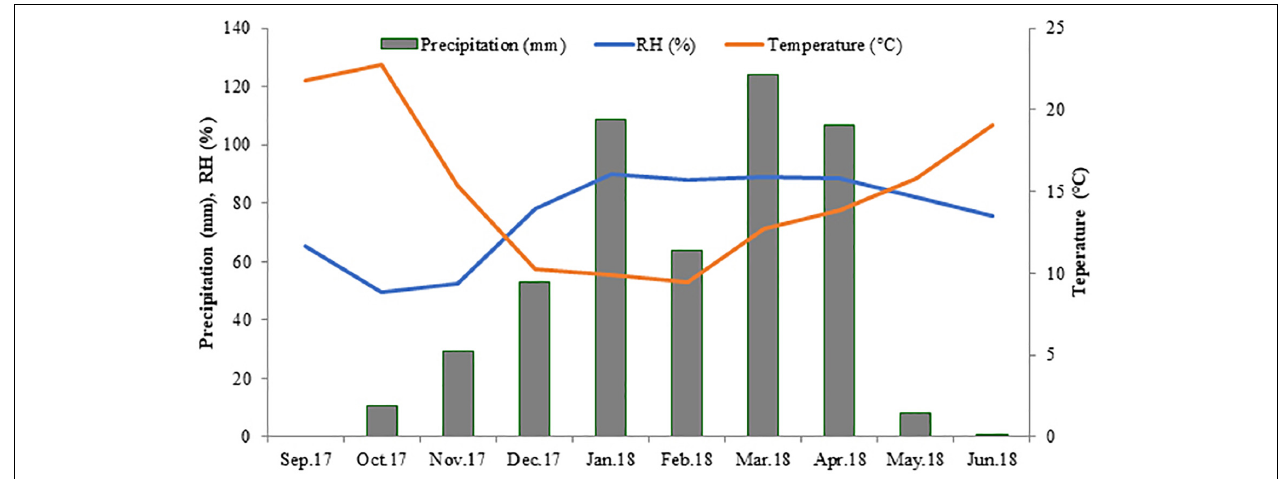
FIGURE 1 | Precipitation (mm), relative humidity (RH, %) and average air temperature ( ◦ C) at Marchouch experimental station, Morocco, during the 2017–2018 cropping